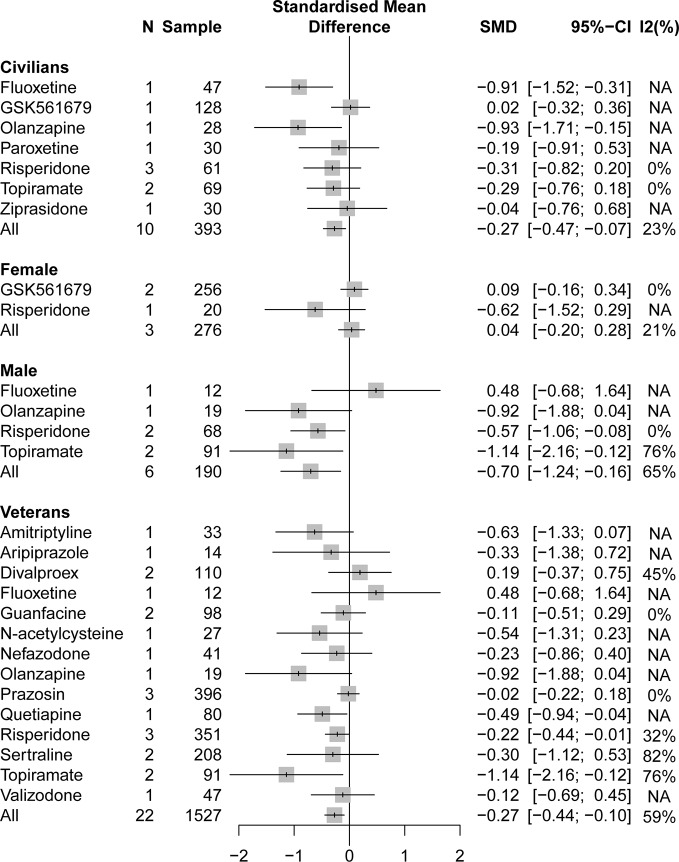
Forest plot based on stratified analyses of different populations and gender of placebo-controlled comparisons in specific drug branch.